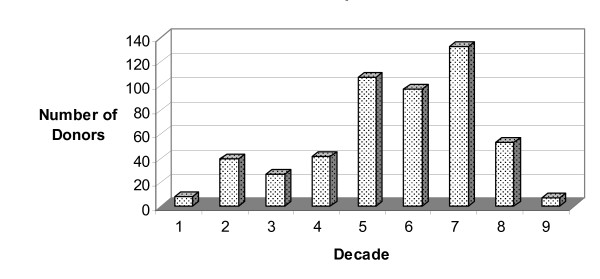
Distribution of knee/tali donors per decade of life. Mean age = 60 years.